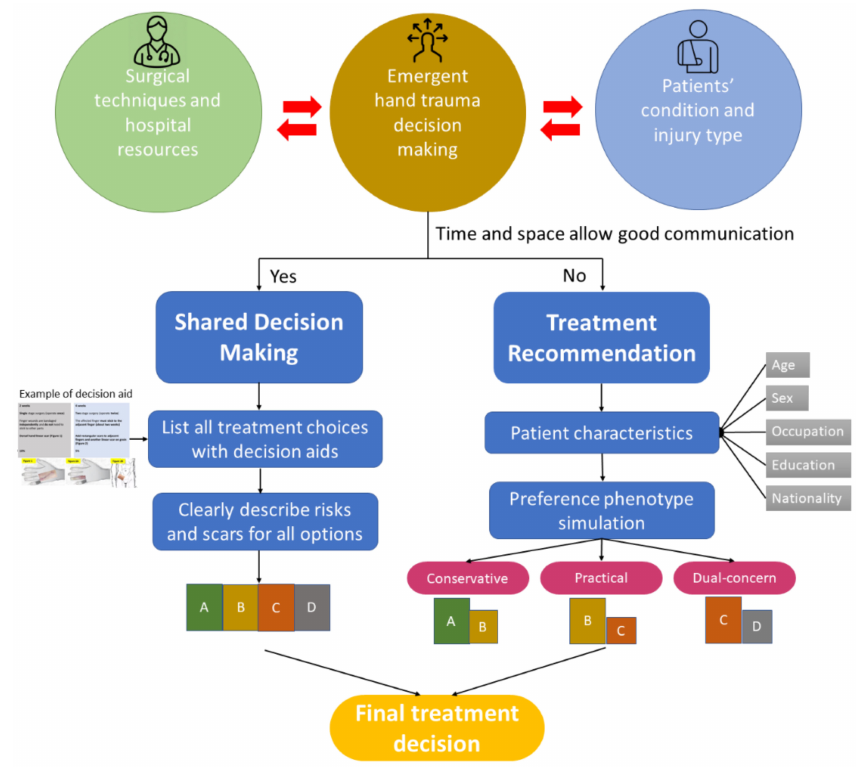
Figure 7. The proposed decision-making model incorporating patient